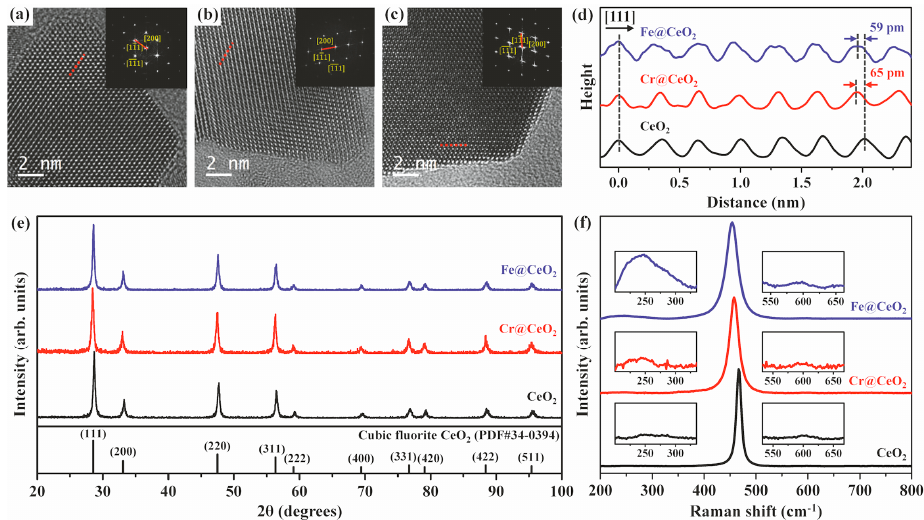
Figure 1. HRTEM images of ( a ) CeO 2 , ( b ) Cr@CeO 2 , and ( c ) Fe@CeO 2 NPs. Insets: The corresponding FFT data. ( d ) Line profile of the red line shown in ( a – c ) for the corresponding NPs. The decrease in the interlayer d-spacings of the [111] plane for Cr@CeO 2 and Fe@CeO 2 NPs is measured as 65 and 59 pm on the six lattice fringes compared to that for CeO 2 NPs, indicating 10.8 and 9.8 pm less per lattice fringe, respectively. ( e ) XRD and ( f ) Raman spectra of CeO 2 , Cr@CeO 2 , and Fe@CeO 2 NPs. Bottom panel in ( e ): Diffraction pattern of cubic fluorite CeO 2 (PDF#34-0394) with Miller indices extracted from the PDF-2 database. Table 1. Crystallite sizes and lattice constants of the cubic fluorite CeO 2 crystal structure estimated through Pawley refinement for XRD spectra acquired from CeO 2 , Cr@CeO 2 , and Fe@CeO 2 NPs. The error rates indicate the 95% confidence